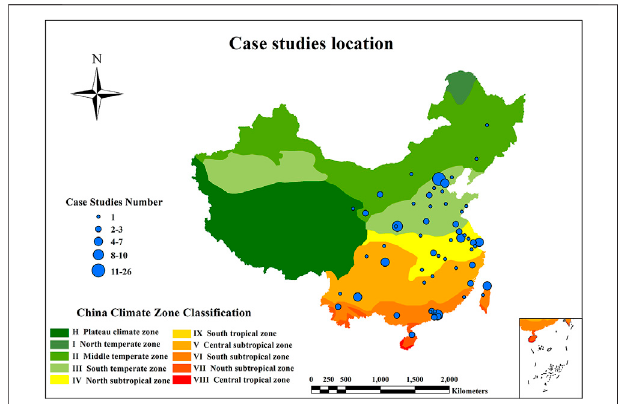
FIGURE 4 | Spatial distribution of case studies, retrieved from Web of Science and Scopus between January 1st, 2000 and July 3rd, 2021.